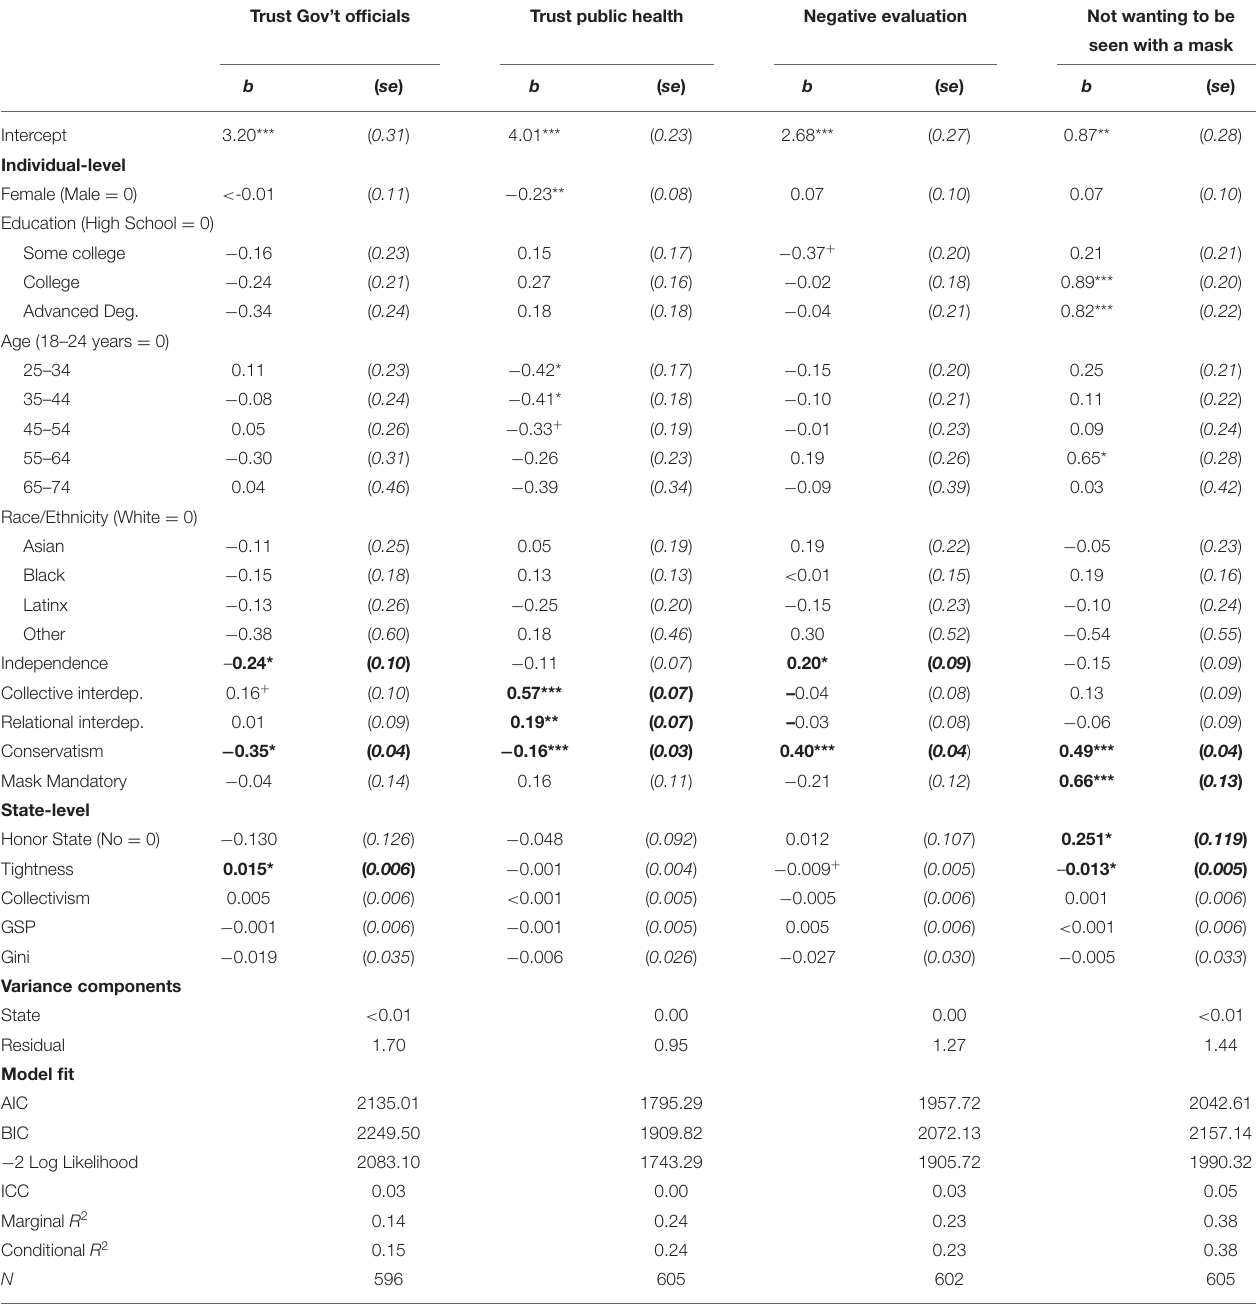
TABLE 5 | Result of multilevel analyses: trust and aversion to